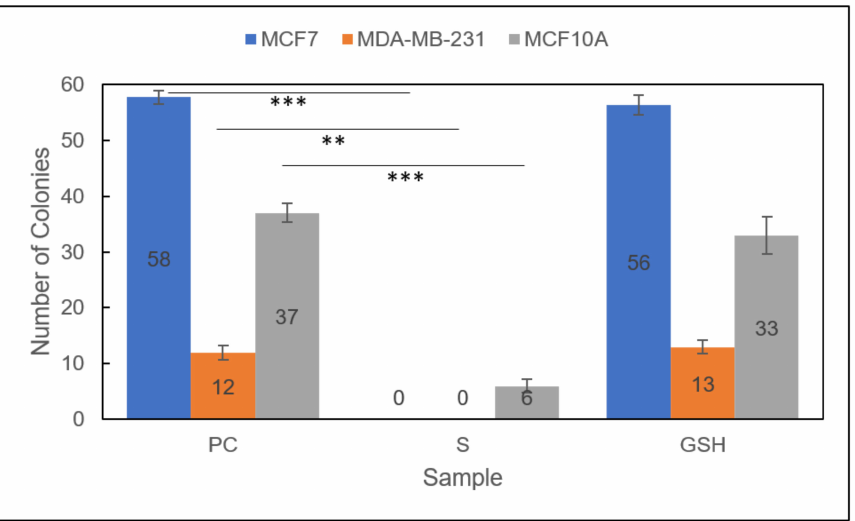
Figure 7. Colony formation capacity of treated Group 2 MCF7 (blue), MDA-MB-231 (orange), and MCF10A (gray) cells. Sample groups include: untreated PC cells, S (Group 2) cells, and GSH-treated cells. Data points represent the mean ± standard deviation. Statistical differences from the positive control are indicated by ** p < 0.01, *** p <